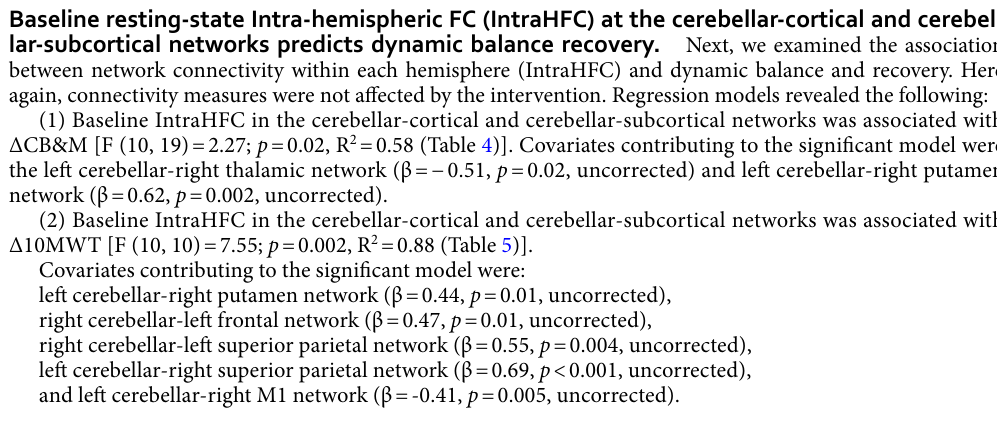
Table 3. Multi-variate regression model of the association between ΔIHFC and recovery of dynamic balance (ΔCB&M). ΔFC delta functional connectivity, M1 motor cortex.